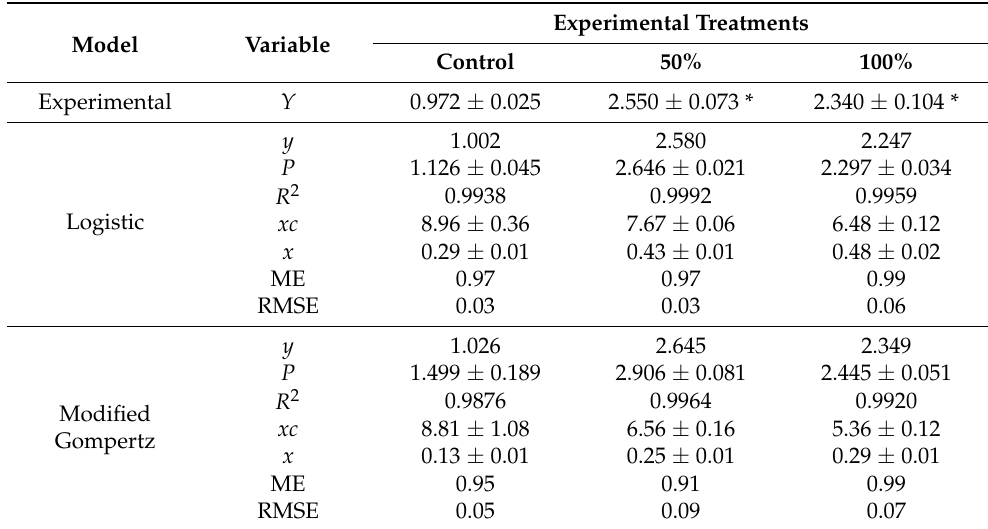
Values are mean ± SD of three replicates; *: significantly different from control treatment values at p < 0.05.